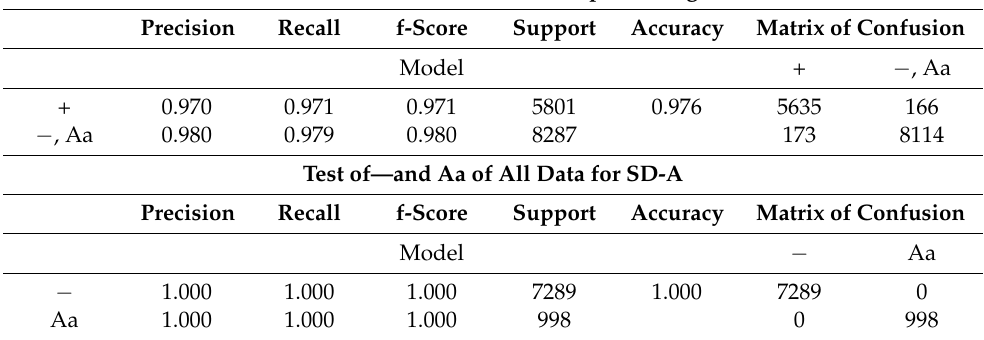
Table 6. Confusion matrix and evaluation criteria for the test using all data for the SB-model_ DSRF _LDA and the